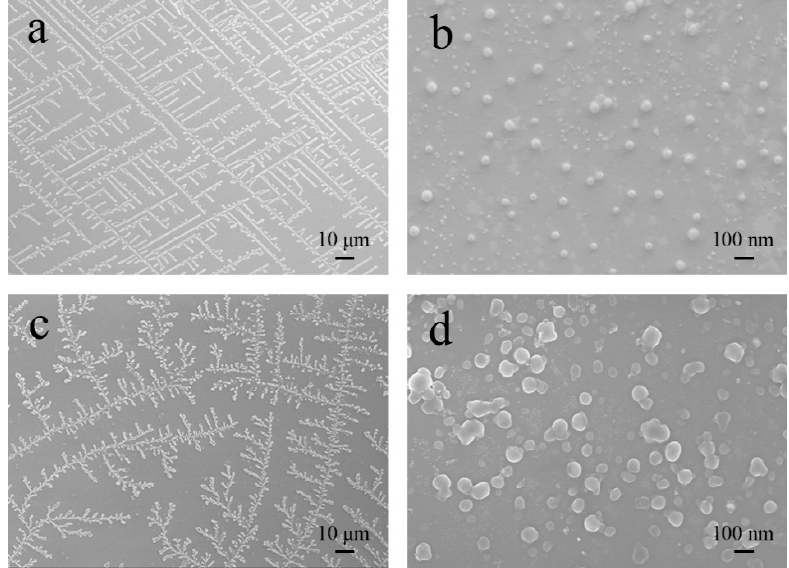
Figure 4. SEM micrographs of ( a ) mPEG 44 -PLGA 9 -PPA 14 showing maze pattern, ( b ) mPEG 44 -PLGA 9 -PPA 14 , ( c ) mPEG 44 -PLGA 20 -PPA 18 showing dendritic pattern and ( d ) mPEG 44 -PLGA 20 -PPA 18 .